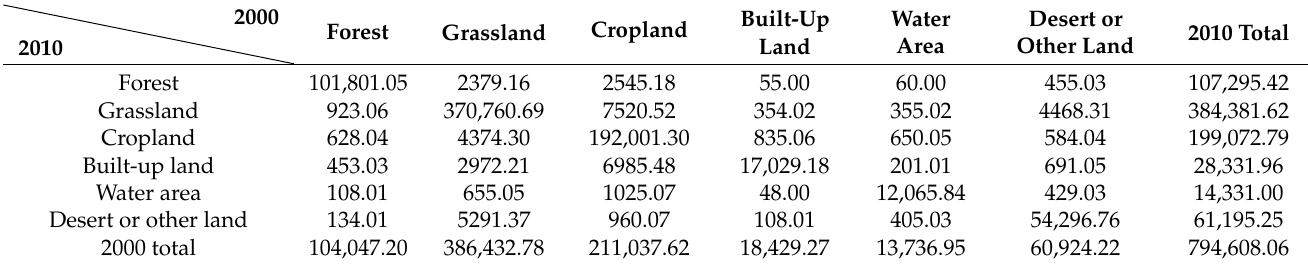
Table 4. Transformed areas of each land cover type in YRB between 2000 and 2010 (unit: km 2 ).